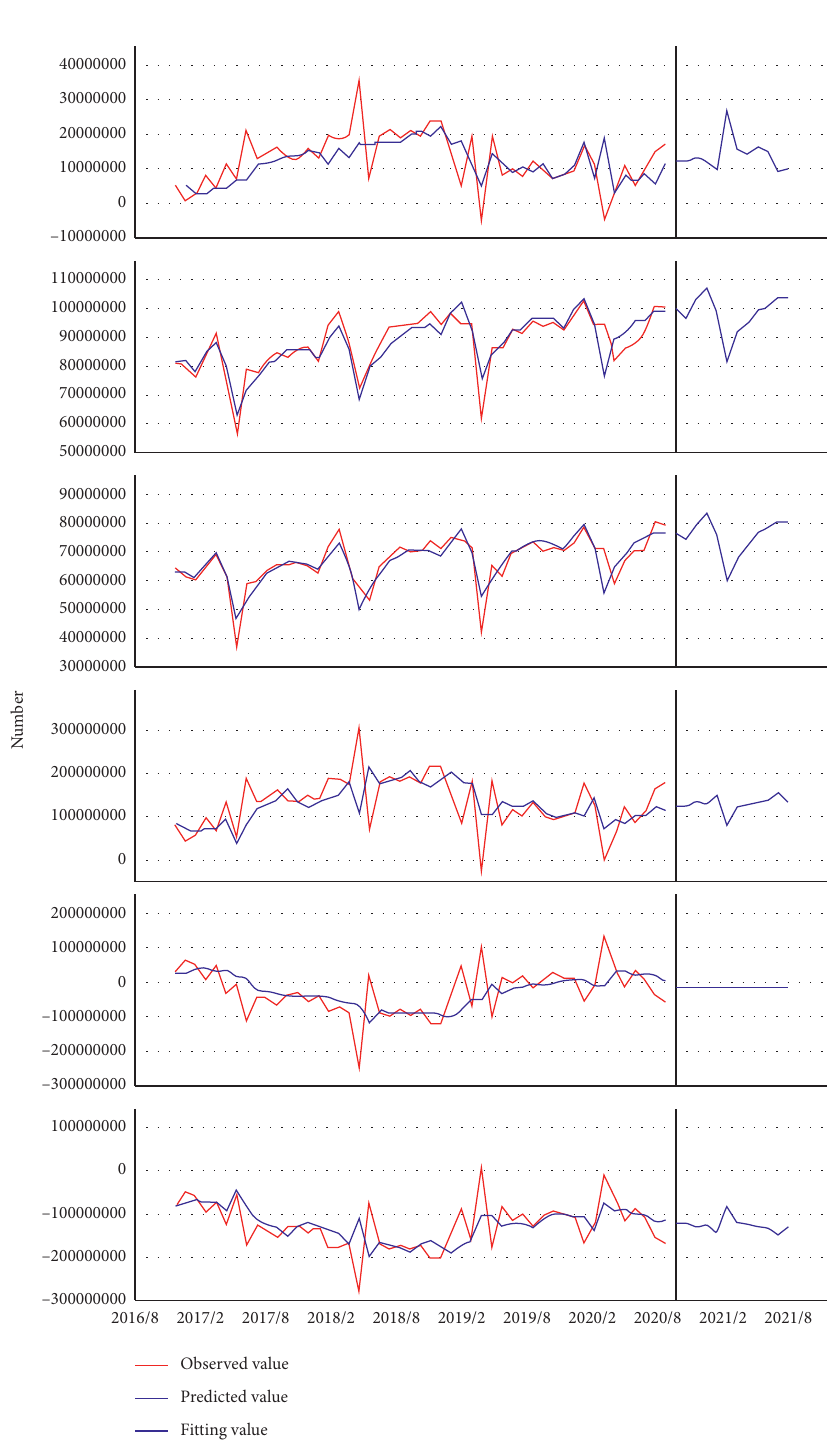
Figure 9: Time series projections for